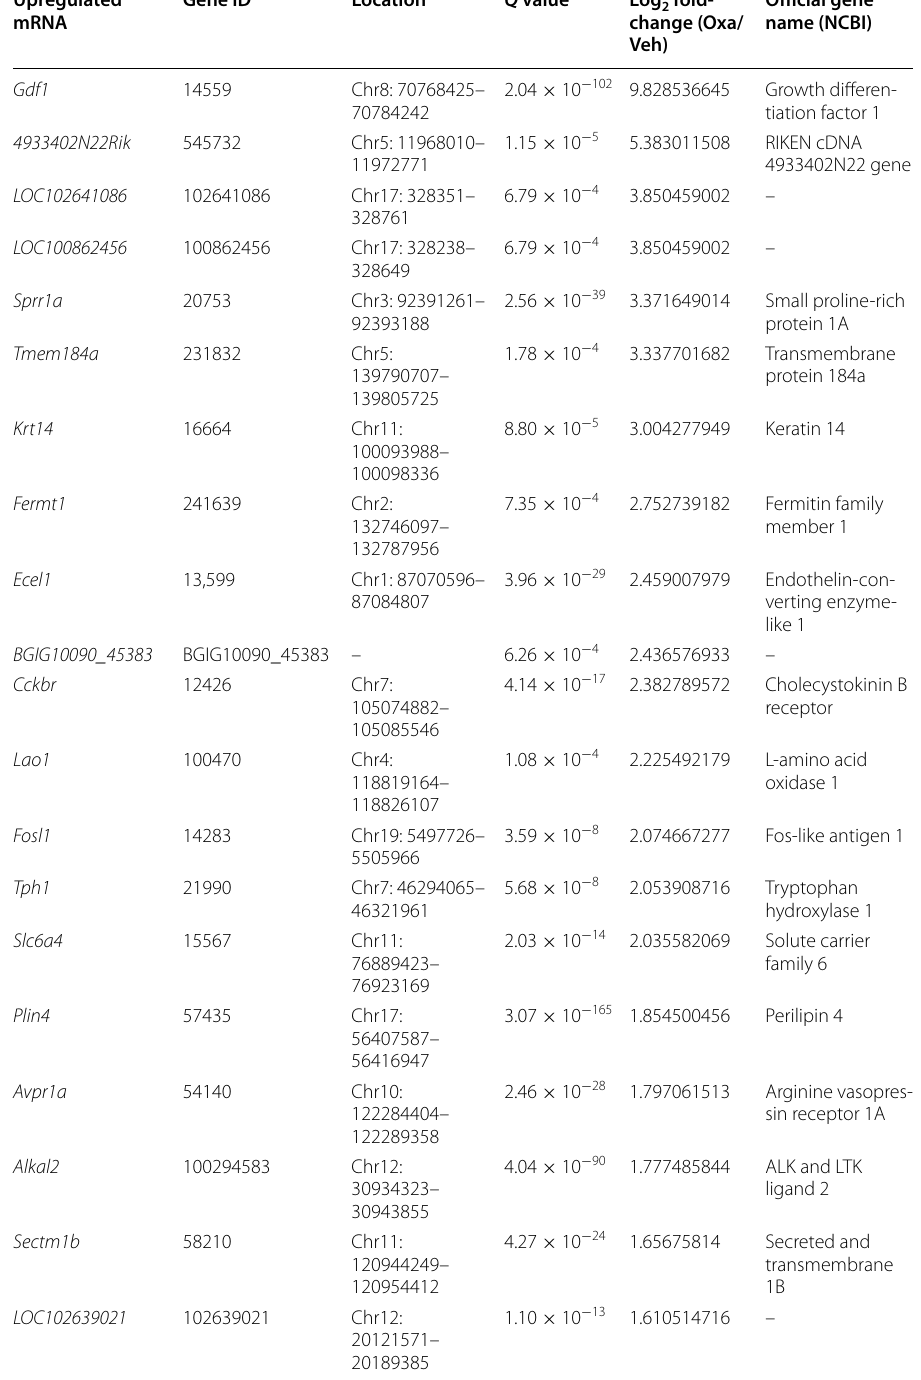
Table 2 Detailed information on the top 20 upregulated DEmRNAs Upregulated Gene mRNA